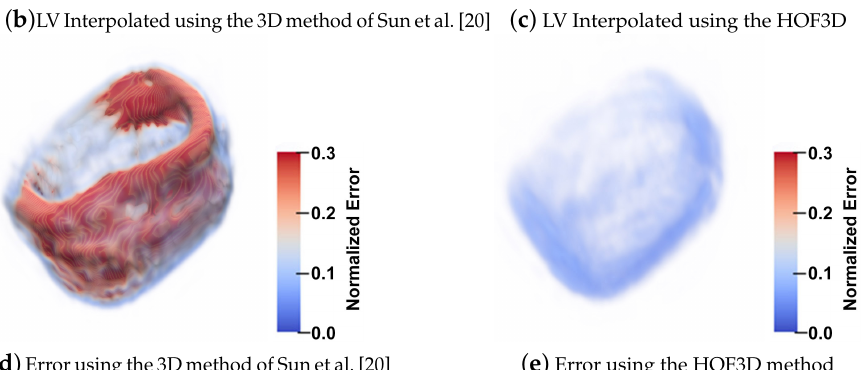
Figure 18. Interpolation Errors for the left ventricle at